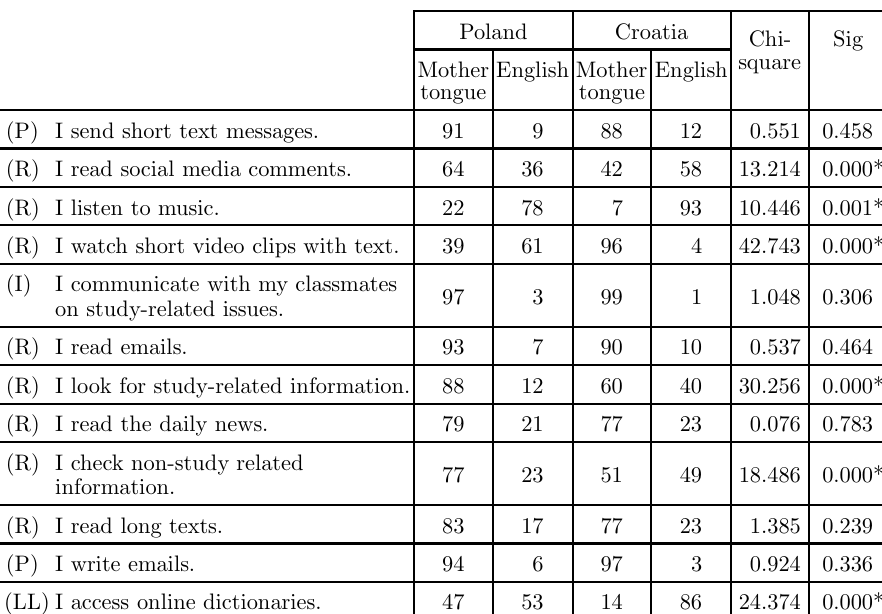
Table 4 Shares of participants by predominant language for online use